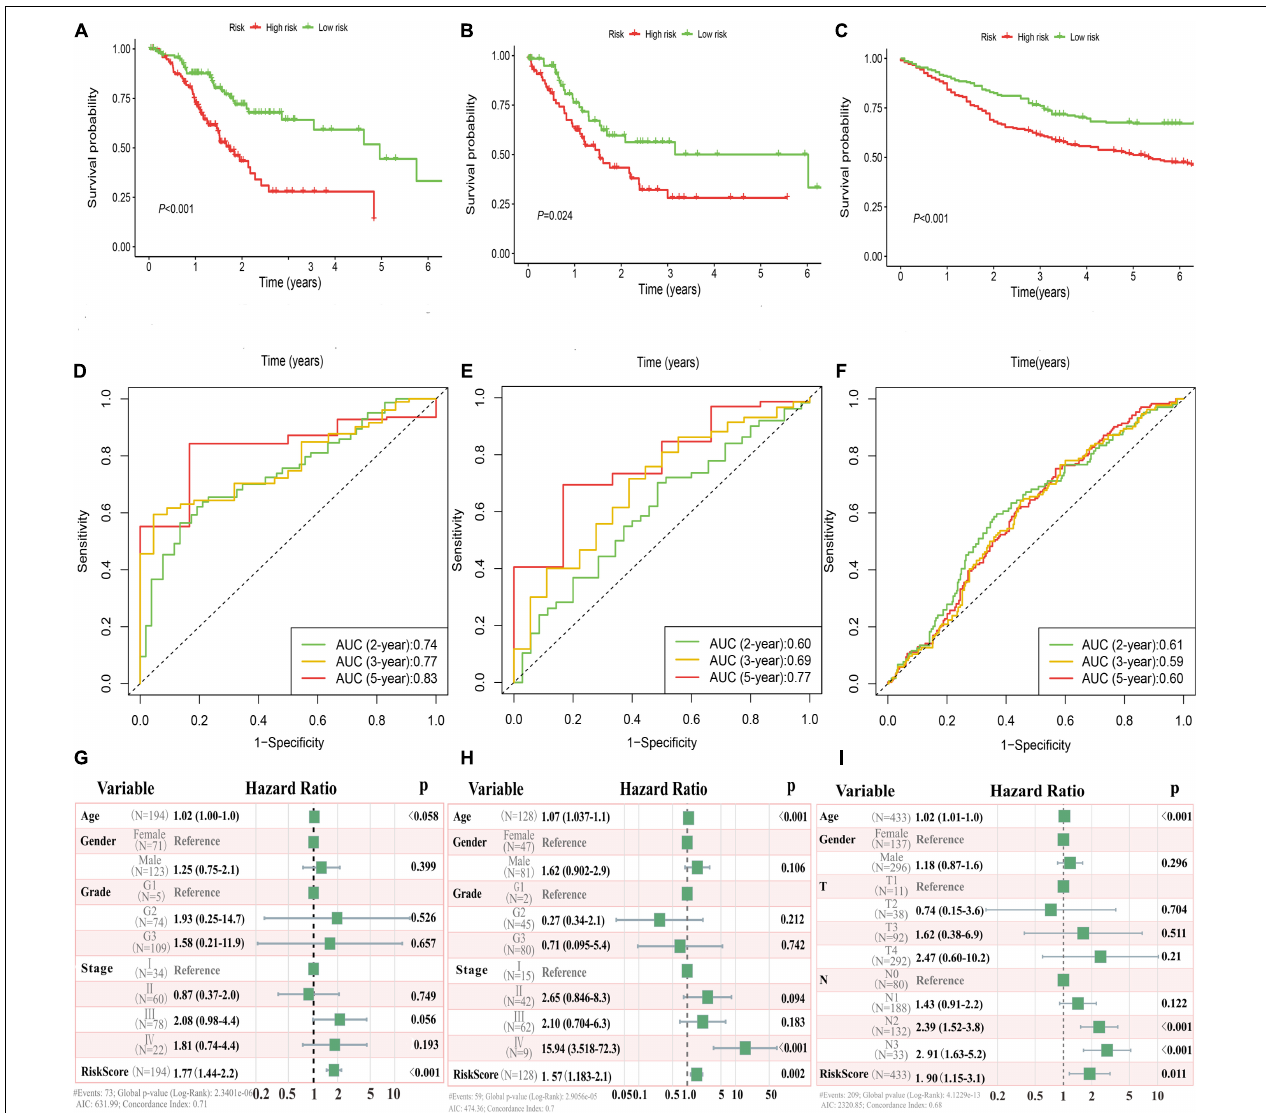
FIGURE 3 | Immune risk signature was associated with GC survival. Kaplan–Meier curves of overall survival based on low- and high-risk groups in the TCGA training cohort (A) , TCGA testing cohort (B) , and GEO validation cohort (C) ; receiver operating characteristic (ROC) curve with AUC values for validation of the immune risk signature’s predictive performance in the TCGA training cohort (D) , TCGA testing cohort (E) , and GEO validation cohort (F) ; forest plot of the multivariate Cox regression analysis delineated the association between immune risk signature and survival in the three cohorts compared with other clinical variables (G–I) ,